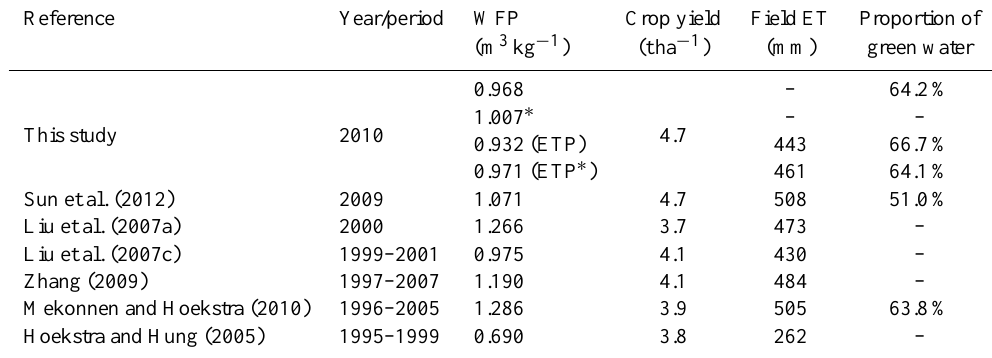
Table 3. Documented results for the WFP of wheat production in China.